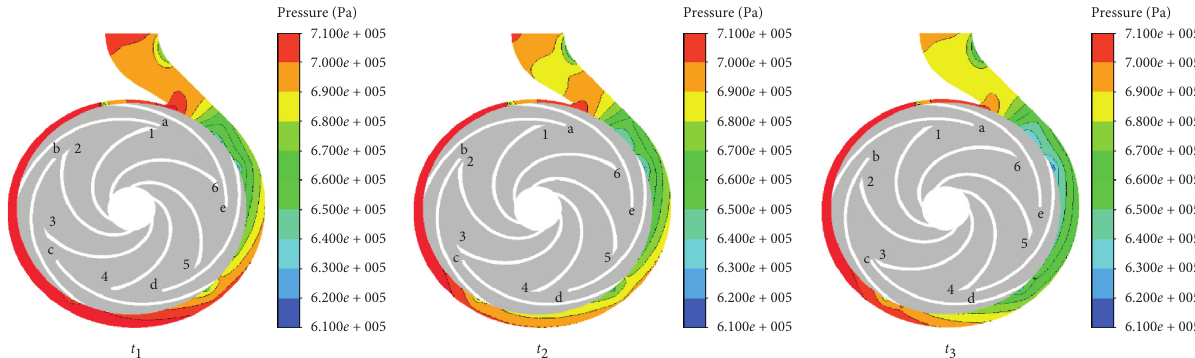
Figure 5: The static pressure distribution of the volute at different